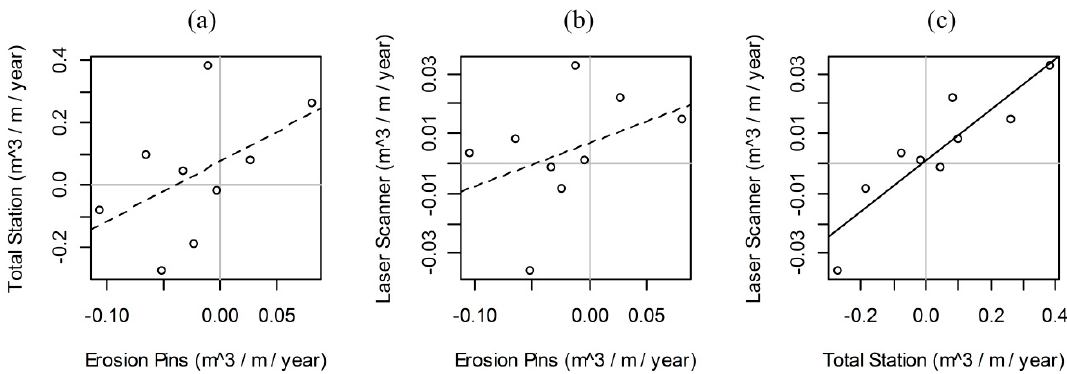
Figure 3. Correlations of bank volume change rate estimates between ( a ) erosion pins and total station (R = 0.51, p = 0.330), ( b ) erosion pins and laser scanner (R = 0.40, p = 0.330), and ( c ) total station and laser scanner (R = 0.89, p = 0.003) for nine sites in the Indian Mill Creek watershed. Solid line indicates significant correlation.